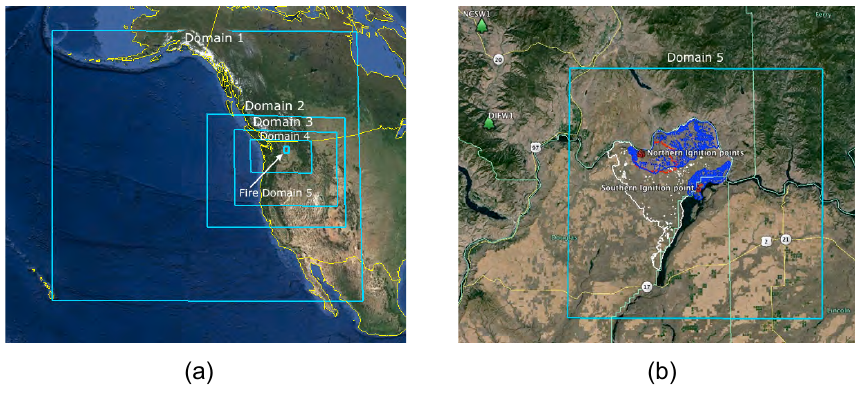
Figure 8. (a) WRF–SFIRE multidomain setup used for the simulation of the 2012 Barker Complex fire (WA). (b) Comparison between the fire perimeters simulated with the constant fuel moisture of 11.6% (red contour), 6.38% (white contour), and with the variable fuel moisture simulated by the fuel-moisture model (blue contour). The remotely sensed fire perimeter detected on 13 September 2012 00:44LT is shown as the green contour. The green tree icons show locations of the Douglas Ingram Ridge (DIFW1) and Cascade Smoke Jumper (NCSW1) stations, reporting 10h fuel moisture.